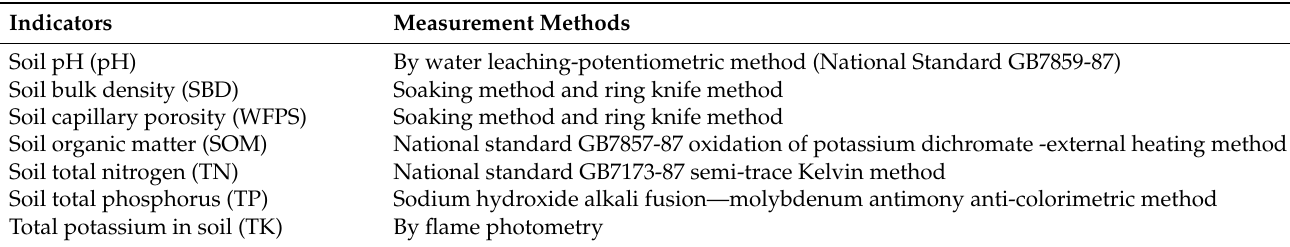
Table 1. Indicators and measurement methods